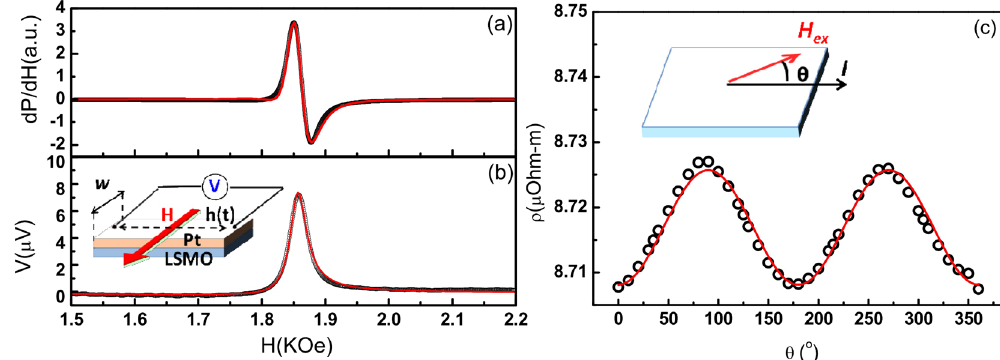
Figure 2. ( a ) The derivative FMR absorption spectrum of LSMO (20 nm)/Pt (6 nm). The red curve indicates the best fit using the first derivative of a Lorentzian function. ( b ) The corespondent voltage spectrum of LSMO (20 nm)/Pt (6 nm). The red curve is the fitting with Eq. 1. The inset illustrates schematically the spin pumping mechanism and the setup of the voltage measurement with the direction of field assigned. H ex , h m ( t ), t LSMO (t Pt ) , and w are the external magnetic field, the time dependent microwave magnetic field, the thickness of LSMO(Pt) layer and the width of bilayer respectively. ( c ) The black open circles are the data of angular dependent resistivity of 20-nm LSMO and the red curve is the best fit to cos 2 θ . The inset shows the configuration of measurement with I denoting the applied current. θ is the angle between I and H ex on the film plane.